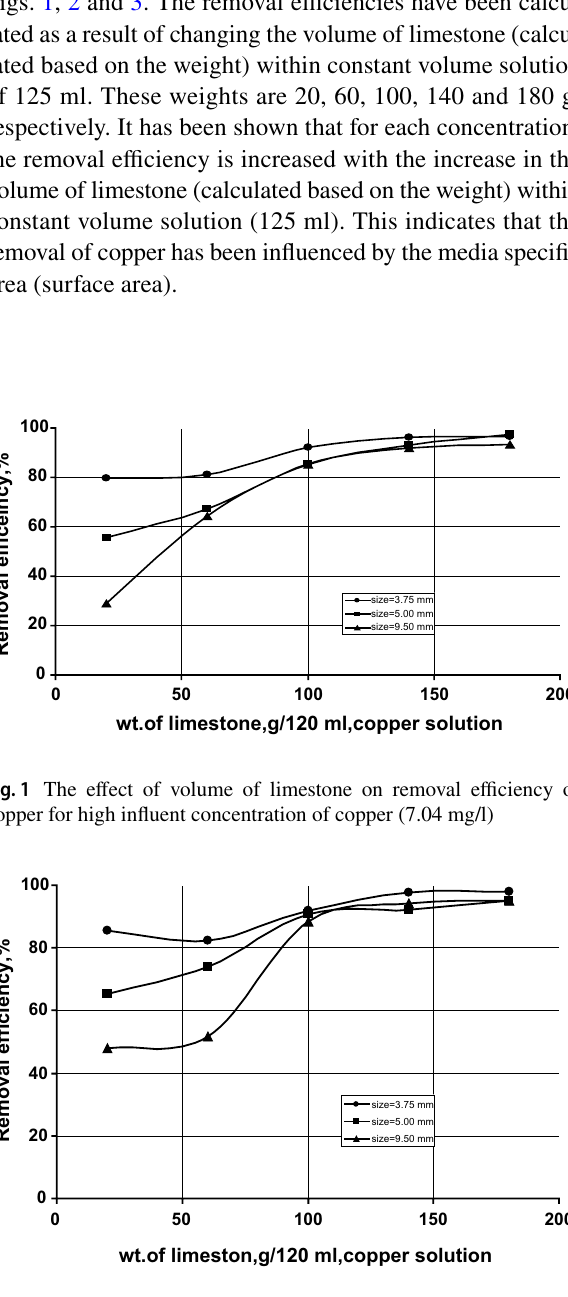
Fig. 2 The effect of volume of limestone on removal efficiency of copper for middle influent concentration of copper (4.39